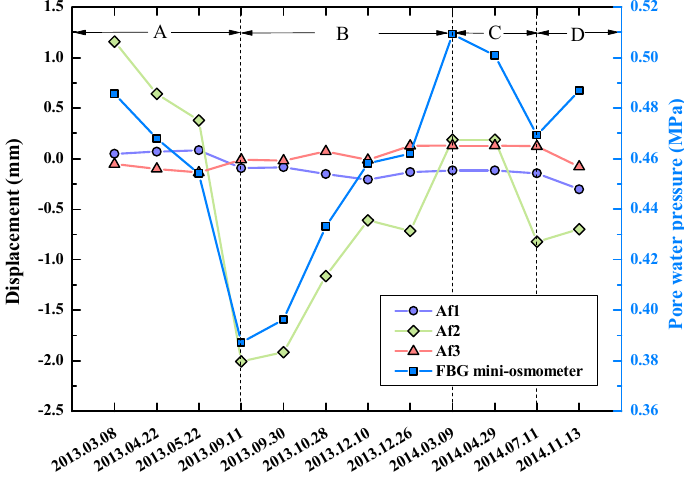
Figure 10. Monitoring results of displacement and pore water pressure during the field test [56]. Af: Aquifer.